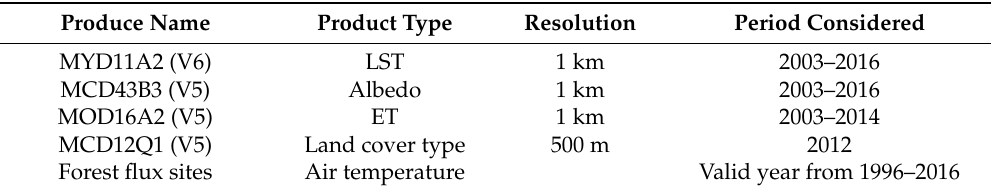
Table 1. List of data products